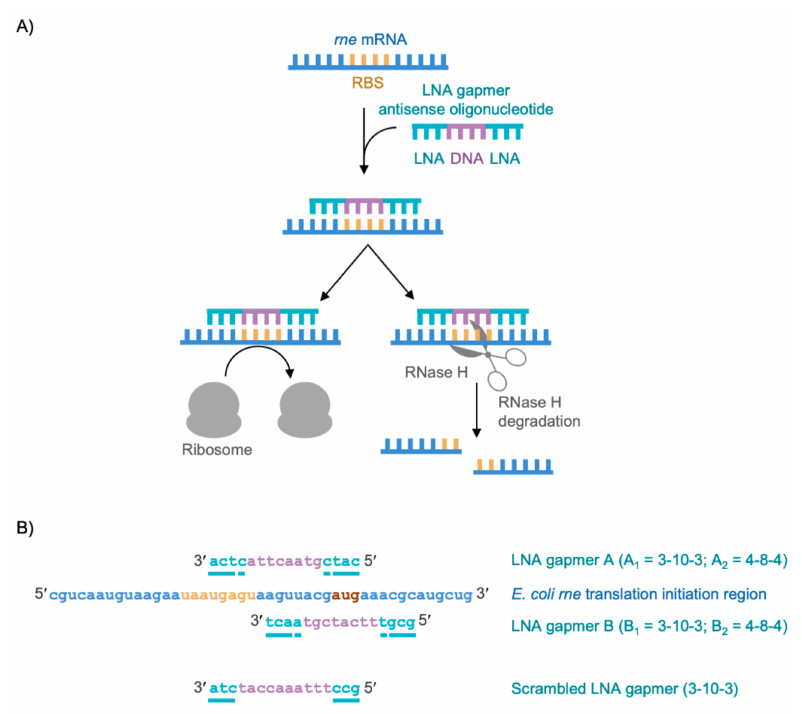
Figure 1. Targeting the translation initiation region of rne mRNA with LNA gapmers. ( A ) An antisense LNA gapmer comprising DNA (mauve) flanked by LNA (teal) binds to the translation initiation region (including the ribosome binding site (RBS), gold) of rne mRNA (blue). This prevents the ribosome (grey) from binding and sterically blocks translation. It also recruits RNase H (grey scissors) which cleaves the rne mRNA to prevent RNase E synthesis. ( B ) LNA gapmer A and LNA gapmer B were designed to be complementary to the translation initiation region of E. coli rne mRNA (blue; RBS, gold; start codon, brown). Scrambled LNA gapmer, which is not complementary to the translation initiation region of E. coli rne mRNA, was also designed. In each of the LNA gapmers, LNA bases (teal/underlined) flank DNA bases (mauve). Each LNA gapmer was synthesised as an LNA 3 -DNA 10 - LNA 3 3-10-3 gapmer (LNA gapmer A 1 /B 1 and Scrambled LNA gapmer). LNA gapmers A and